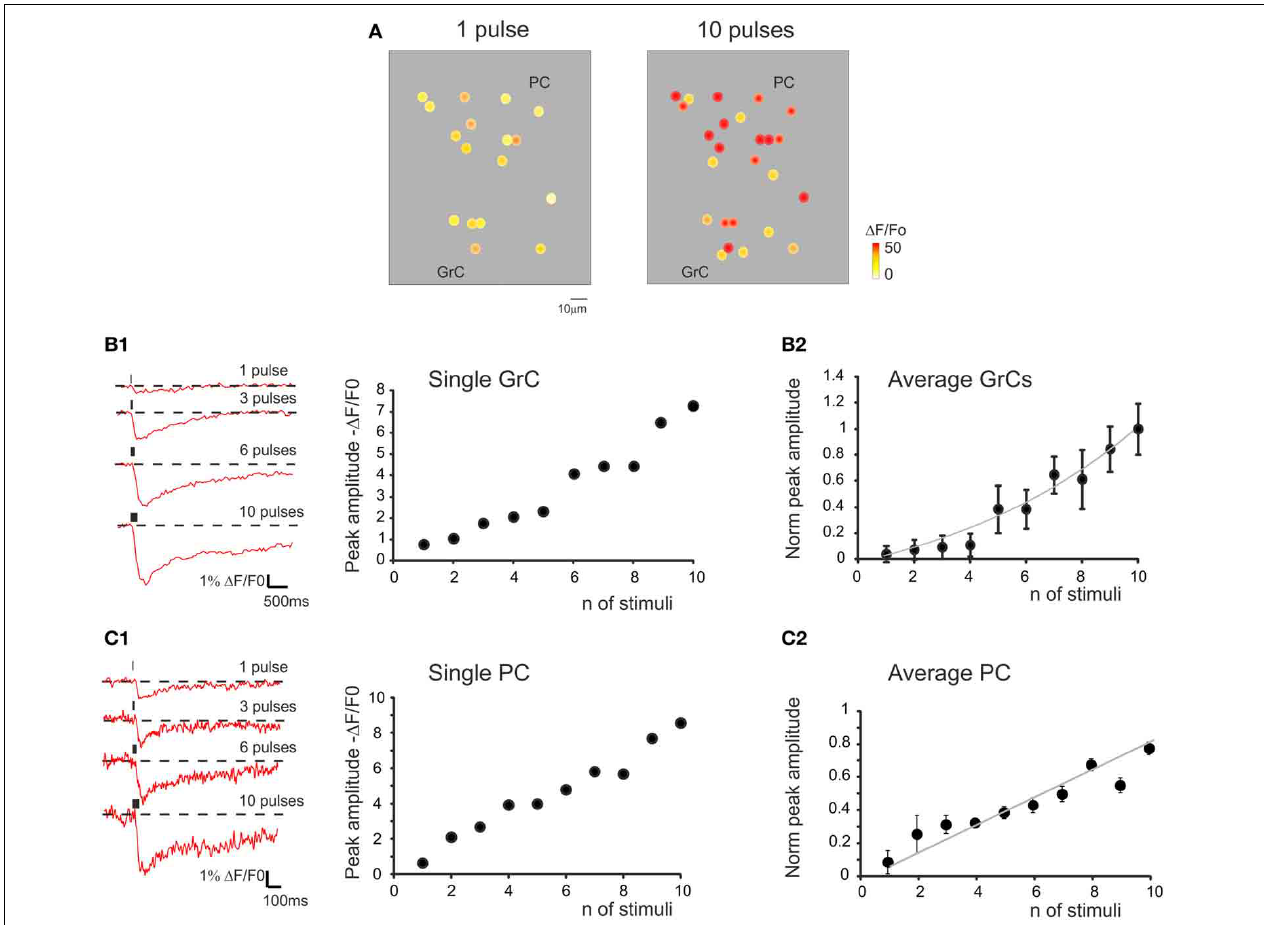
normalized peak amplitude from one to ten stimuli ( n = 35 cells in six experiments; exponential fitting R 2 = 0 . 94; p < 0 . 01; mean ± s.e.m.). (C1) Traces on the left illustrate the time course of (cid:3) F/F 0 obtained from a PC in response to an increasing number of mossy fiber stimuli at 50Hz. The plot on the right shows the values of (cid:3) F/F 0 . Note the increase in normalized peak amplitude from one to ten stimuli. (C2) The plot shows the average values of (cid:3) F/F 0 . Note the increase in normalized peak amplitude from one to ten stimuli ( n = 13 cells in five experiments; linear fitting R 2 = 0 . 81; p < 0 . 05; mean ± s.e.m.). In all these experiments, (cid:3) F/F 0 was measured at the peak of Fura-2AM calcium signals elicited by mossy fiber